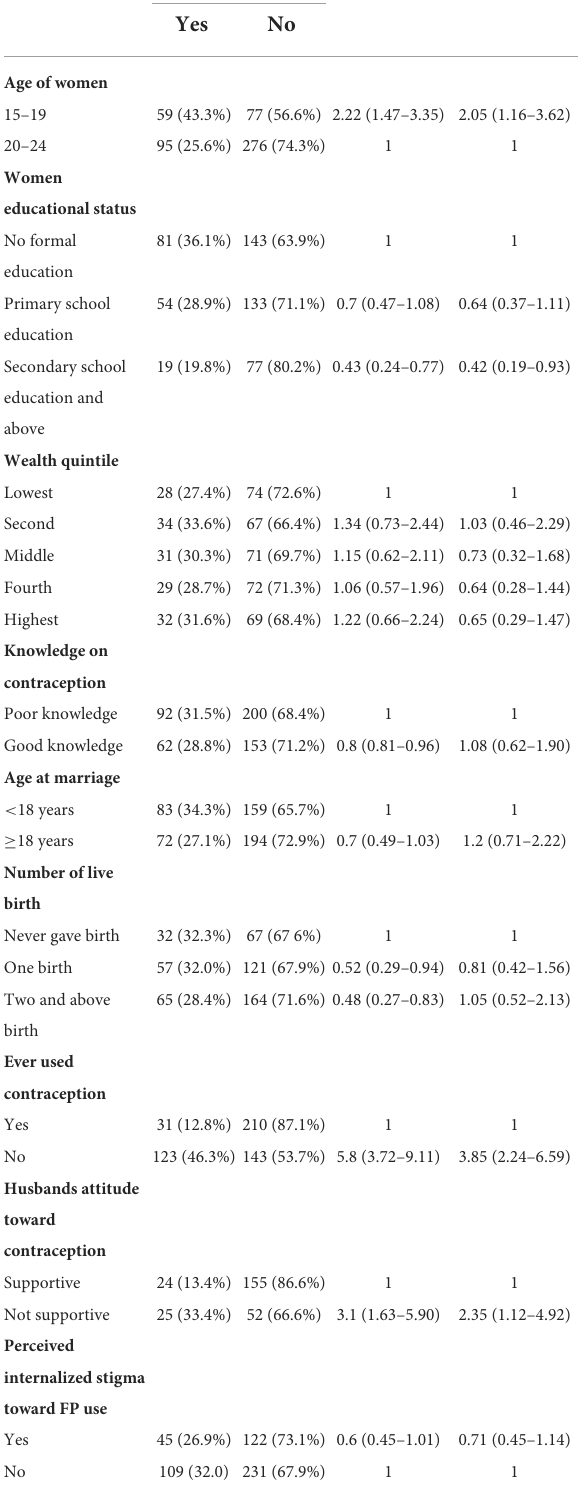
TABLE 4 Bivariate and multivariate binary logistic regression analyses for unmet need for contraception and associated factors among young married women in the Haramaya HDSS, eastern Ethiopia,